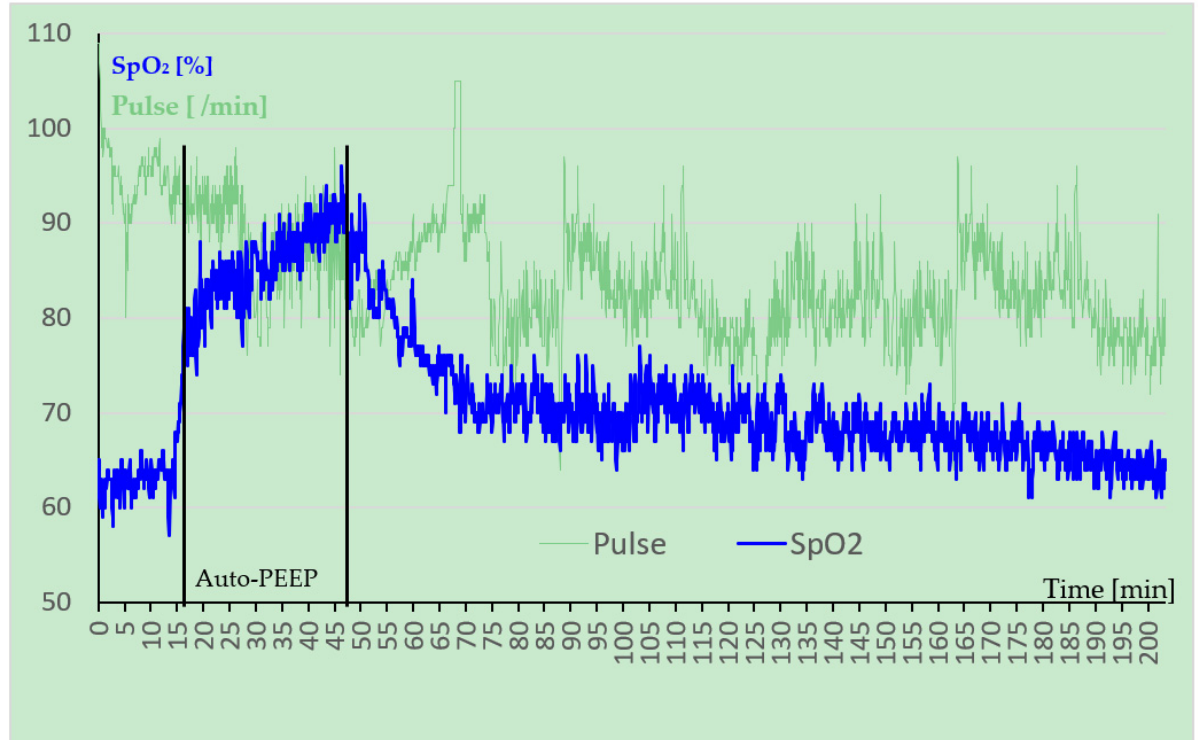
Figure 2. Time course of SpO 2 (blue) and pulse (green) in AP-Pat at 4380 m. The black lines indicate beginning and end of Auto-PEEP